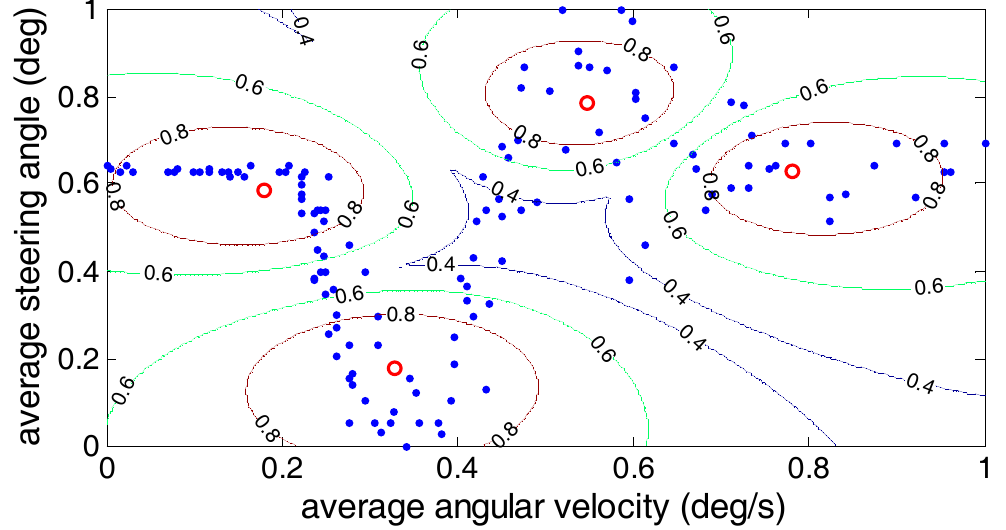
Figure 11. Visualization of the classification results of the driver’s steering intention based on the fuzzy C-means algorithm.